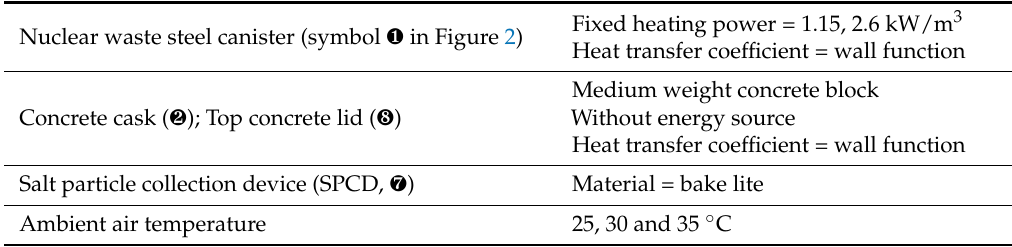
Table 2. Parameters specified in numerical